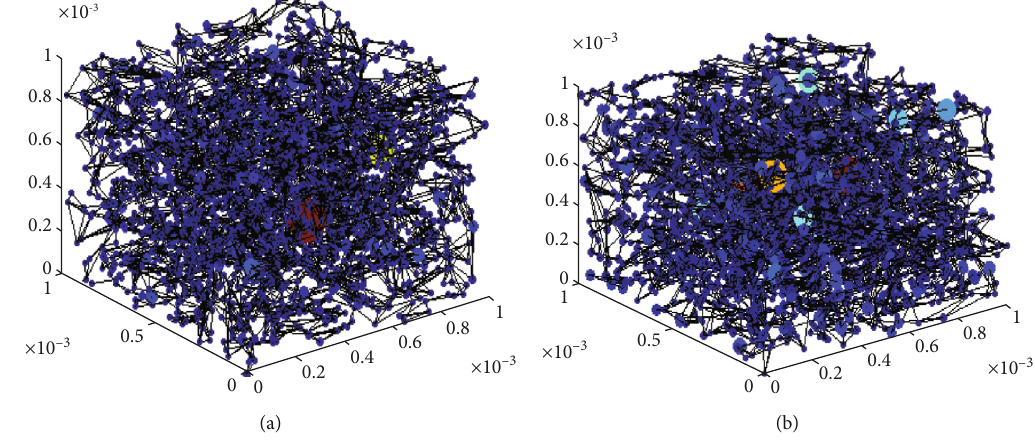
Figure 3: The microcosmic network models of rock sample #1 (a) and rock sample #2 (b). Table 2: Gas fl ow velocity under di ff erent pressure